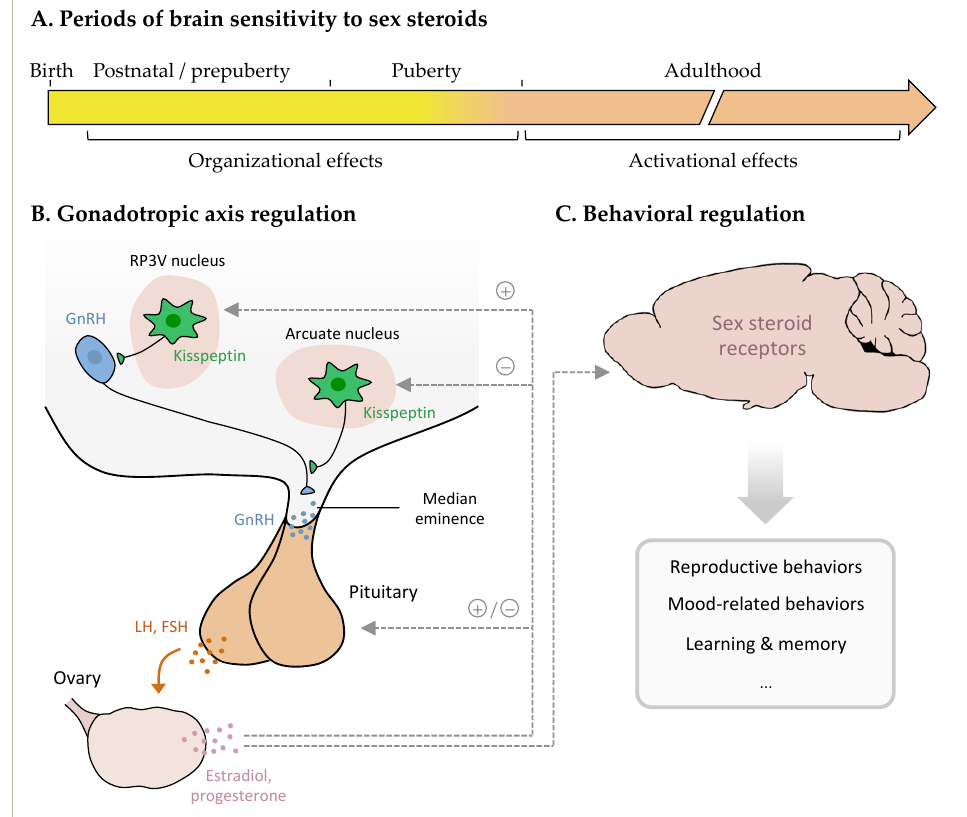
Figure 1. ( A ). In females, the ovaries start synthesizing and liberating sex steroids from postnatal day 7. During the postnatal/prepubertal and pubertal periods, sex steroids play an important role in the organization of neural structures involved in the regulation of the gonadotropic axis and behaviors. During adulthood, sex steroids play an activation role. ( B ). Kisspeptin neurons from the RP3V and arcuate nucleus project on GnRH neurons, thereby stimulating GnRH liberation, which acts on the pituitary to stimulate the liberation of LH and FSH and consequently the ovarian secretion of gonadal hormones. In turn, sex steroids exert positive or negative feedbacks on kisspeptin neurons and the pituitary. ( C ). Ovarian sex steroids act on the brain to activate the neural structures underlying the mentioned behaviors. RP3V, rostral periventricular area of the third ventricle; GnRH, Gonadotropin-Releasing Hormone; LH, Luteinizing Hormone; FSH, Follicle Stimulating